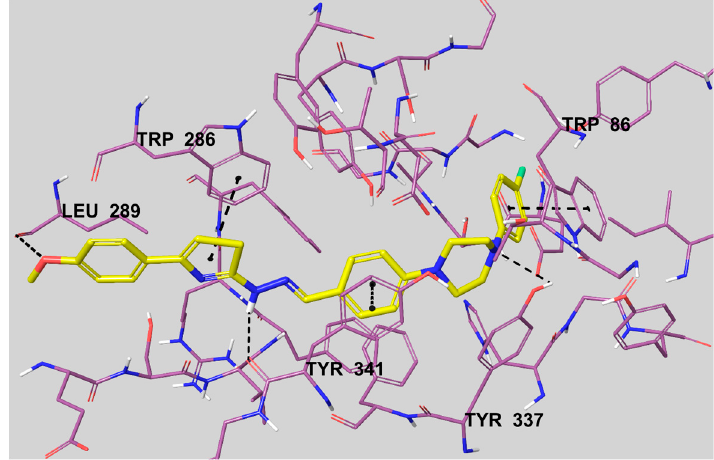
Figure 5. The interacting mode of compound 3c in the active region of AChE. The inhibitor, colored with yellow, and the important residues, colored with purple, in the active site of the enzyme are presented by a tube model.